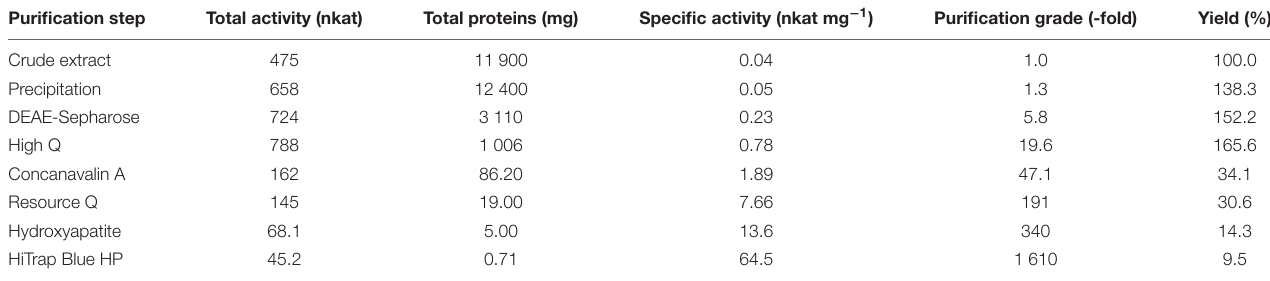
FIGURE 1 | Purification and identification of the protein with zeatin cis–trans isomerase activity. (A) Typical conversion of zeatin isomers (0.2 mM) by maize kernel extracts after incubated in 100 mM McIlvaine buffer containing 20 mM MgCl 2 , 0.1 mM FAD and 2.0 mM dithiothreitol, at 37 ◦ C under white fluorescent light for 2 h; determined by UFLC; graph depicts average of three technical replicates with standard deviation. (B) SDS-PAGE of the individual protein purification steps: 1, crude extract; 2, extract after protein precipitation; 3, fraction from DEAE-Sepharose; 4, High Q; 5, Concanavalin A; 6 Resource Q; 7 Bio-Scale CHT5-I; 8 HiTrap Blue HP; 9, MW marker, 100 and 50 kDa indicated by arrows. (C) Isoelectric focusing gel with the sample after HiTrap Blue HP (silver-stained lane); the rest of the gel slab was sliced, proteins extracted and activity detected in the band indicated by the asterisk. (D) SDS-PAGE of the isolated active protein: 1, MW marker, 100 and 50 kDa indicated by arrows; 2, purified active protein; the vertical black line denotes combining of two image parts. (E) SDS-PAGE of the isolated recombinant ZmNPP protein: 1, MW marker; 2, purified enzyme from the yeast growth medium. TABLE 1 | Purification of the protein with zeatin cis–trans -isomerase activity from